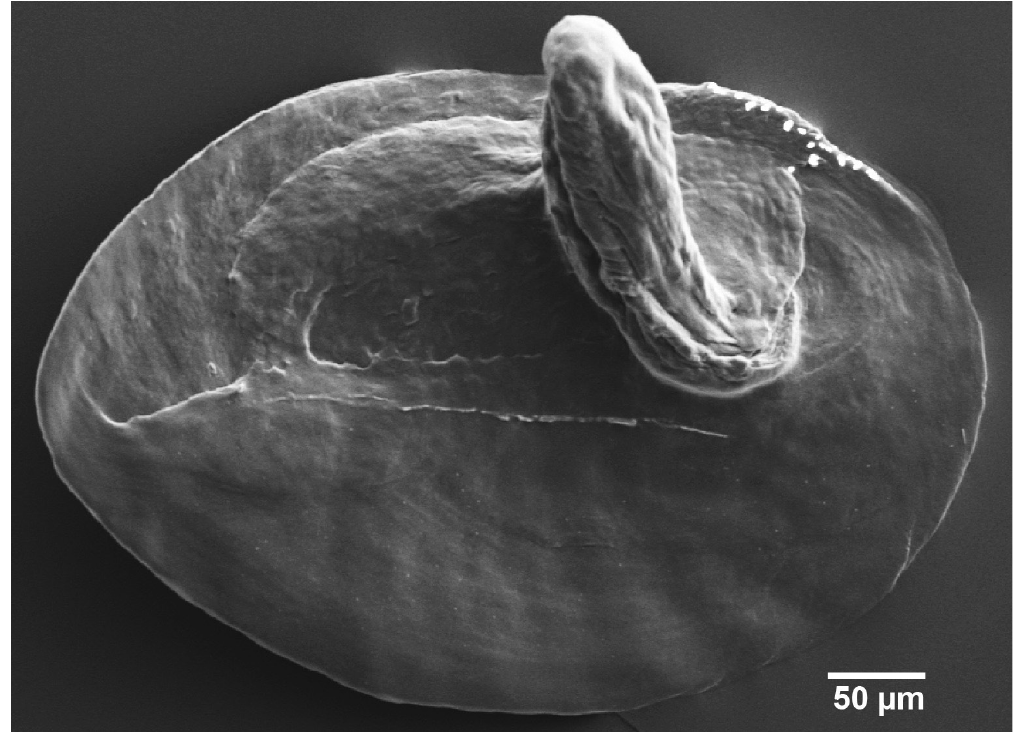
Fig. 7. Operculum of Catapyrgus jami sp. nov.